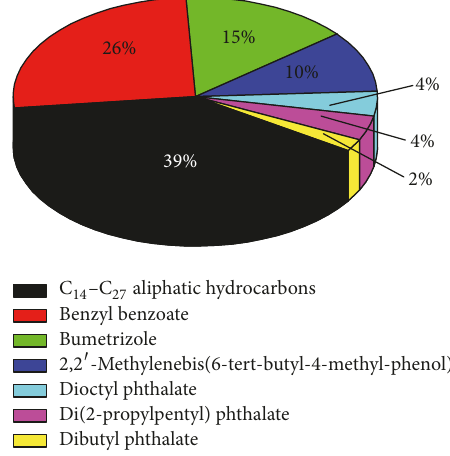
Figure 8: Analysis result of vacuum extraction in the liquid-phase